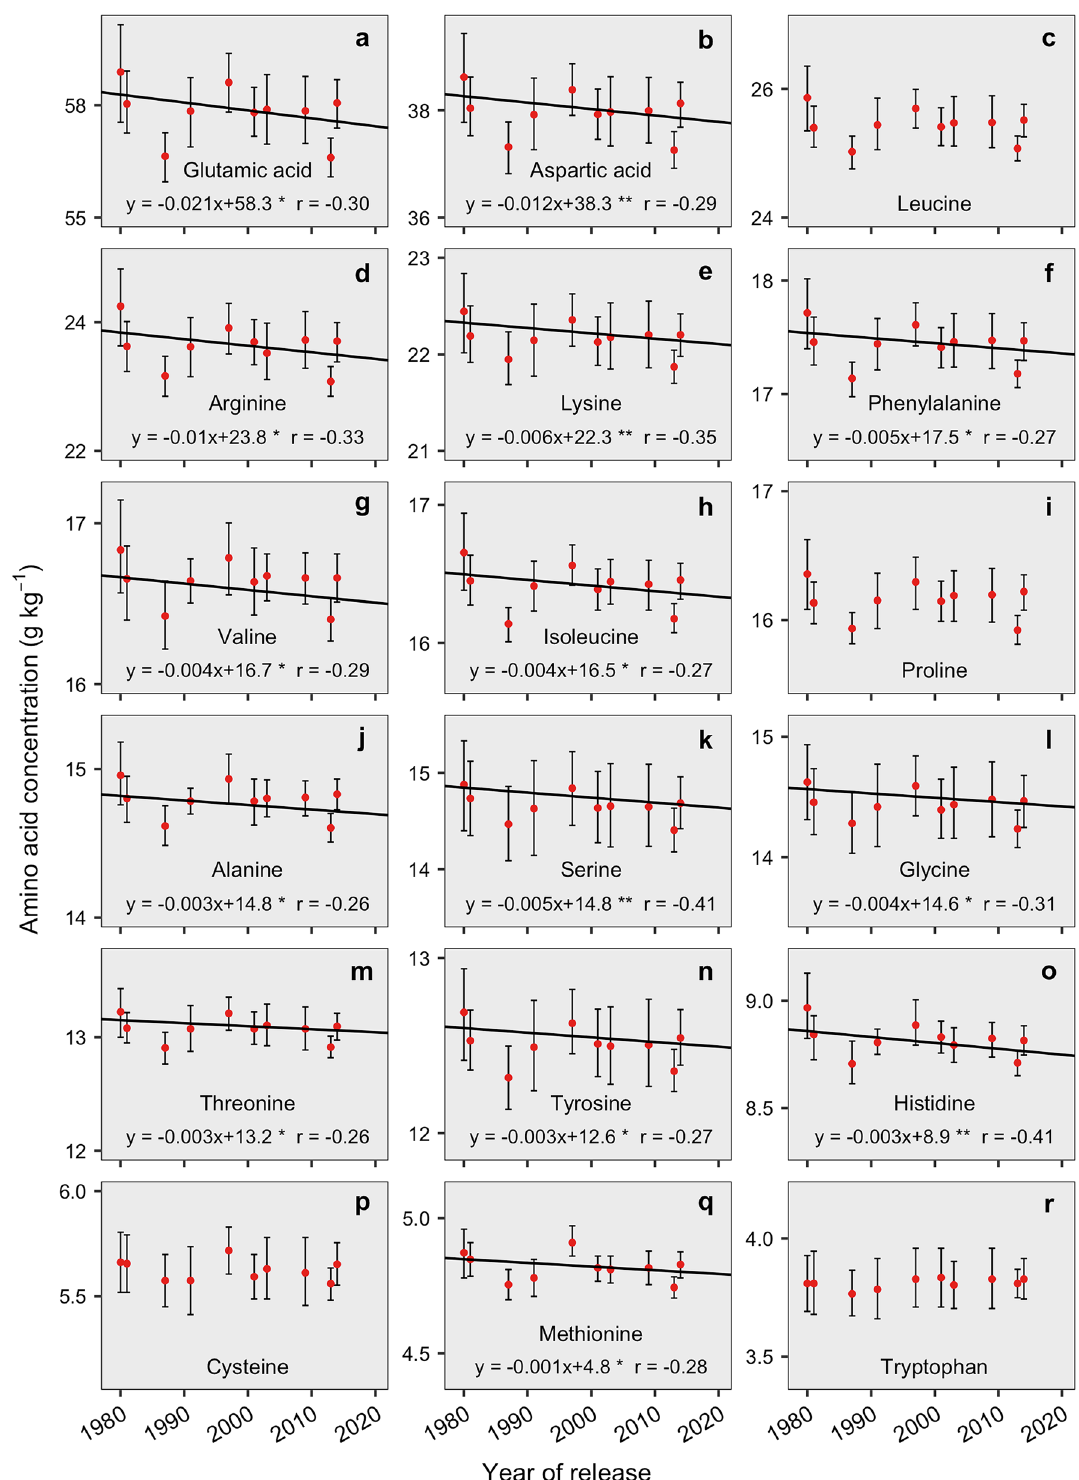
Figure 2. Relationship between glutamic acid ( a ), aspartic acid ( b ), leucine ( c ), arginine ( d ), lysine ( e ), phenylalanine ( f ), valine ( g ), isoleucine ( h ), proline ( i ), alanine ( j ), serine ( k ), glycine ( l ), threonine ( m ), tyrosine ( n ), histidine ( o ), cysteine ( p ), methionine ( q ), tryptophan ( r ), and year of release of 13 soybean genotypes released from 1980 to 2014. Each point represents the average between the two N treatments and genotypes (if more than one per year). Solid black lines denote the AA genetic gain fitted model. Asterisks indicate significance of the coefficient: *** P < 0.001; ** P < 0.01; * P < 0.05. The r value represents the Pearson correlation